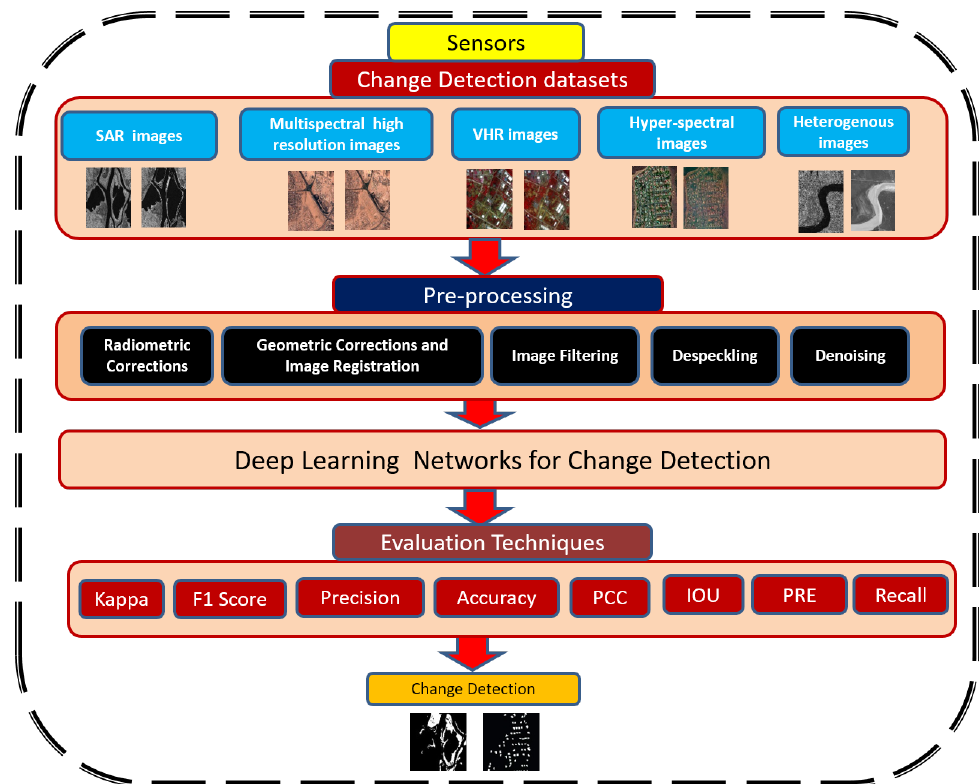
Figure 3. The workflow of the change detection